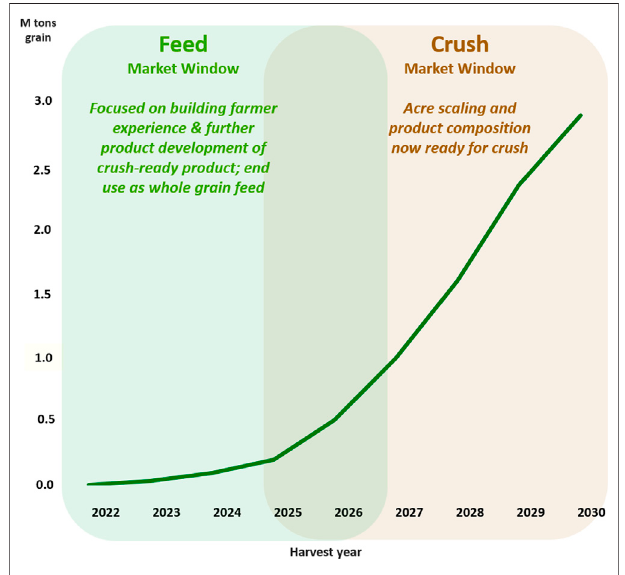
FIGURE 4 | CoverCress commercialization forecast in M tons of harvested